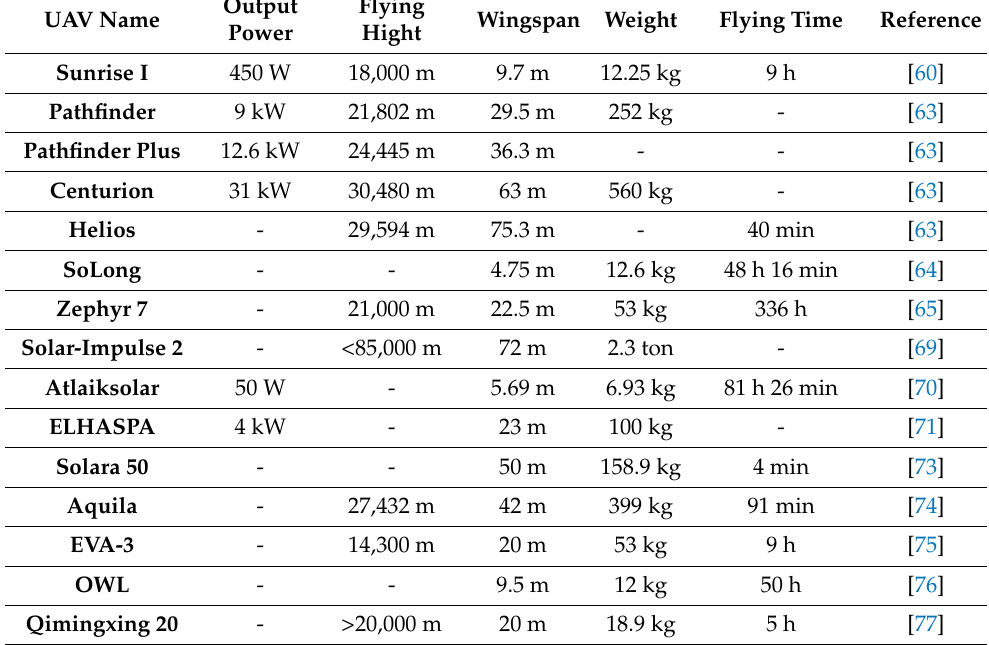
Table 3. Comparison of solar-powered